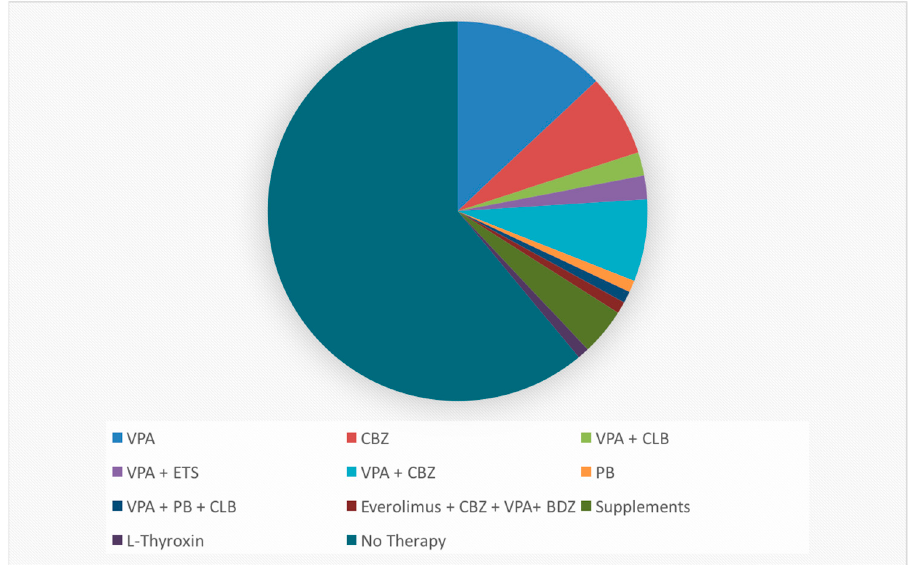
Figure 1. Ongoing therapies at EEG recording in our patients. VPA: valproic acid, ETS: ethosuximide, PB: phenobarbital, CBZ: carbamazepine, CLB: clobazam.